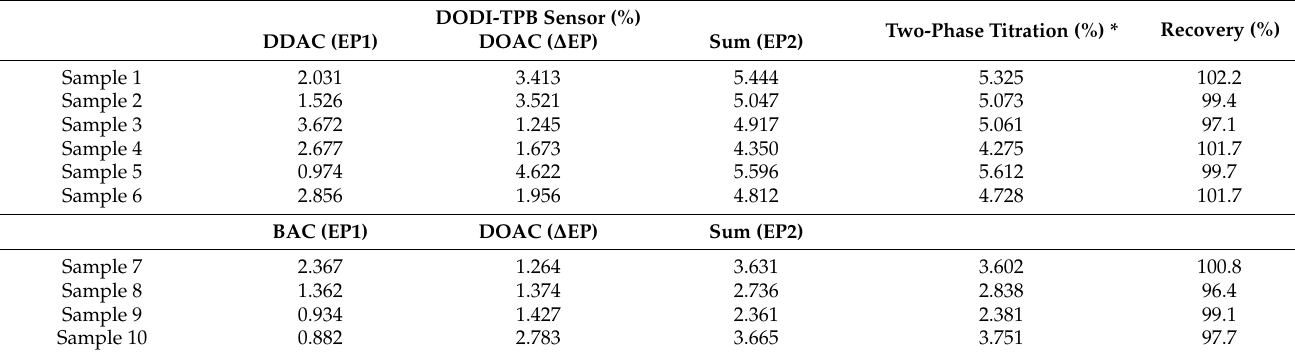
Table 8. Potentiometric determinations of cationic surfactants in COVID-19 disinfecting formulations using NaDDS as a titrant ( c = 4 × 10 − 3 M) and the potentiometric sensor DODI-TPB as an endpoint